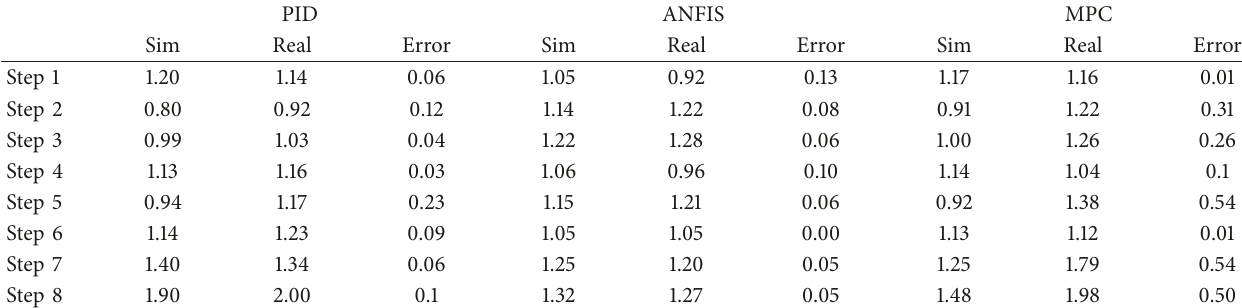
Table 9: Peaks of acceleration errors [m/s 2